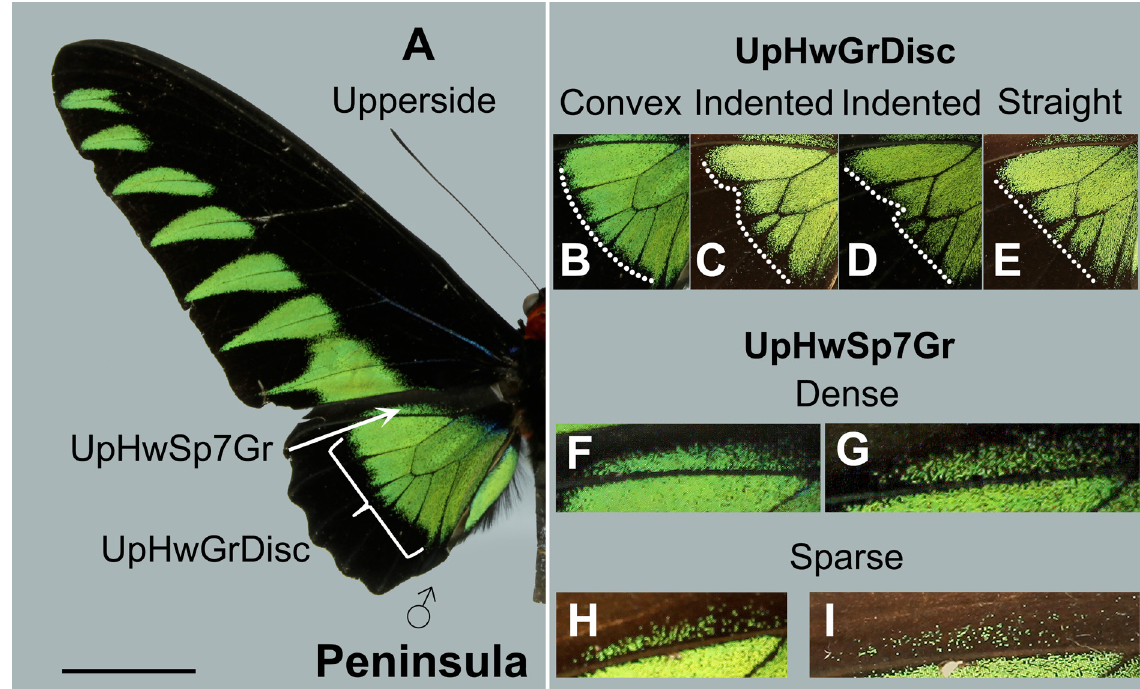
Fig. 3. Illustrations of categorical characters in males. Scale bar = 2.00 cm. See Table 1 for